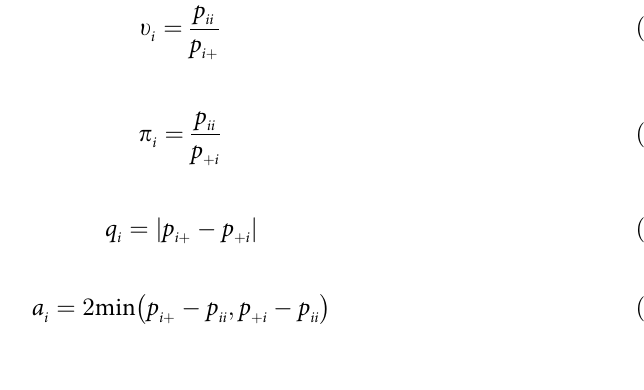
is the row total of category i in i+ is the total area of the map tot